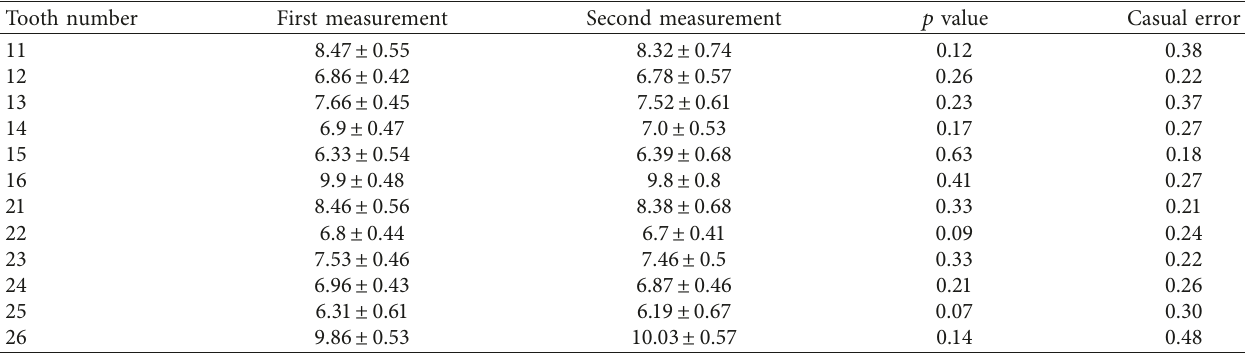
Table 2: Analysis of error of the method using the paired t -test and Dahlberg’s formula.